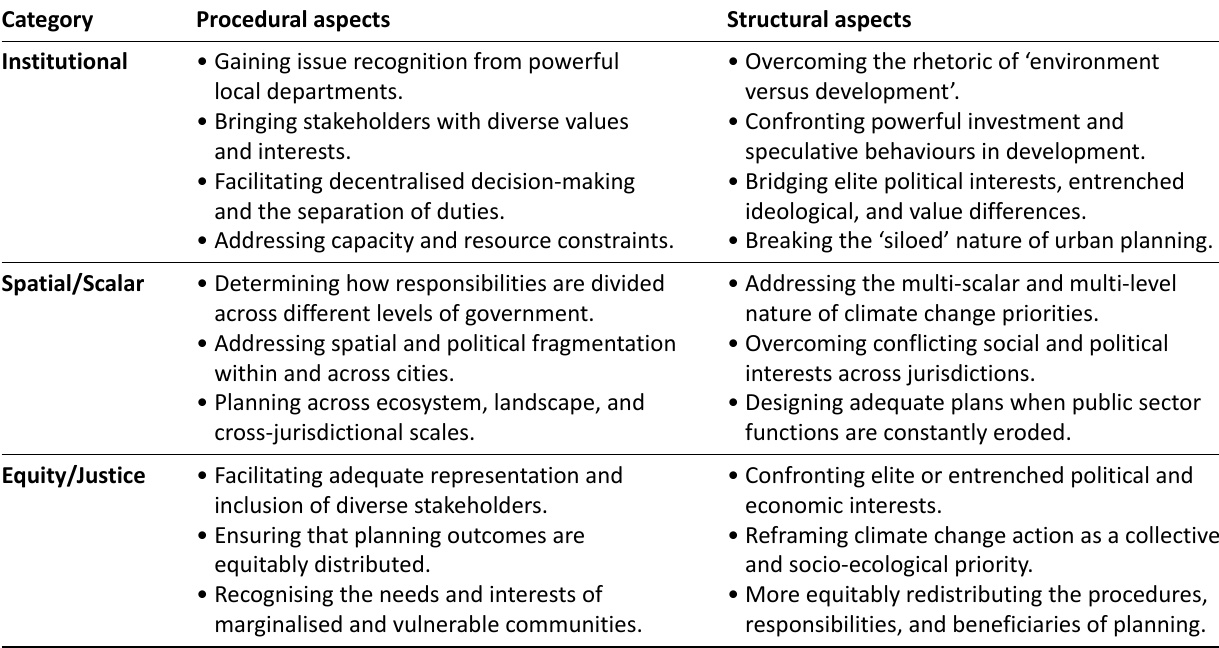
Table 1. Key dilemmas faced by cities in advancing ambitious and inclusive climate